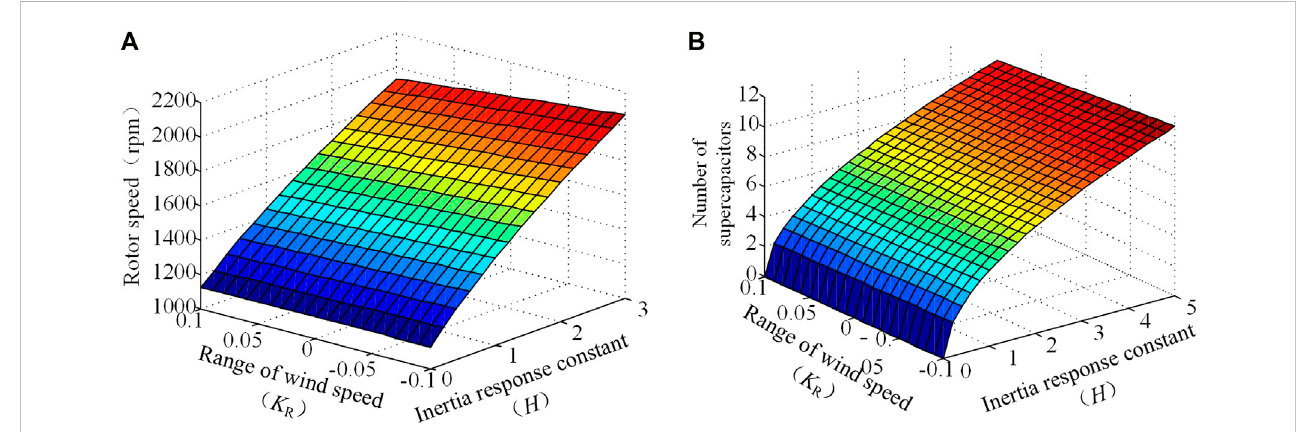
FIGURE 4 Minimum speed or number of modules required for inertia response constants of different